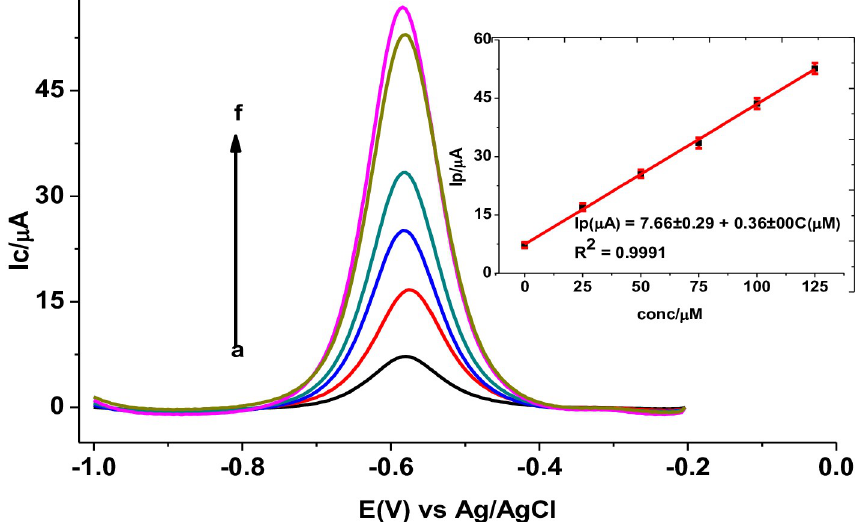
Fig 10. Representative background corrected SWAdCSV of PARS/GCE in pH 7.0 PBS containing tablet sample spiked with various concentrations of standard MTZ (a–e: 0.0, 25.0, 50.0, 75.0, 100.0, and 125.0 μ M, respectively). Inset: plot of mean ± SD (n = 3) of Ip versus spike concentration of